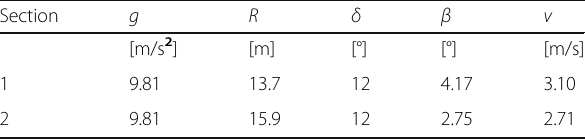
Table 3 Velocity values of the flow obtained according to the Hungr et al. (1984) formula